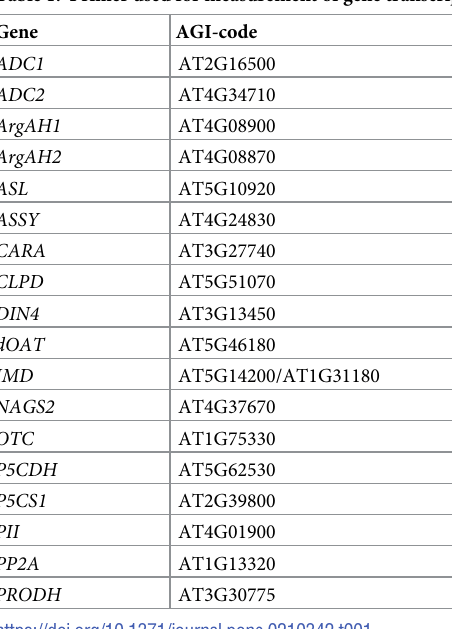
Table 1. Primer used for measurement of gene